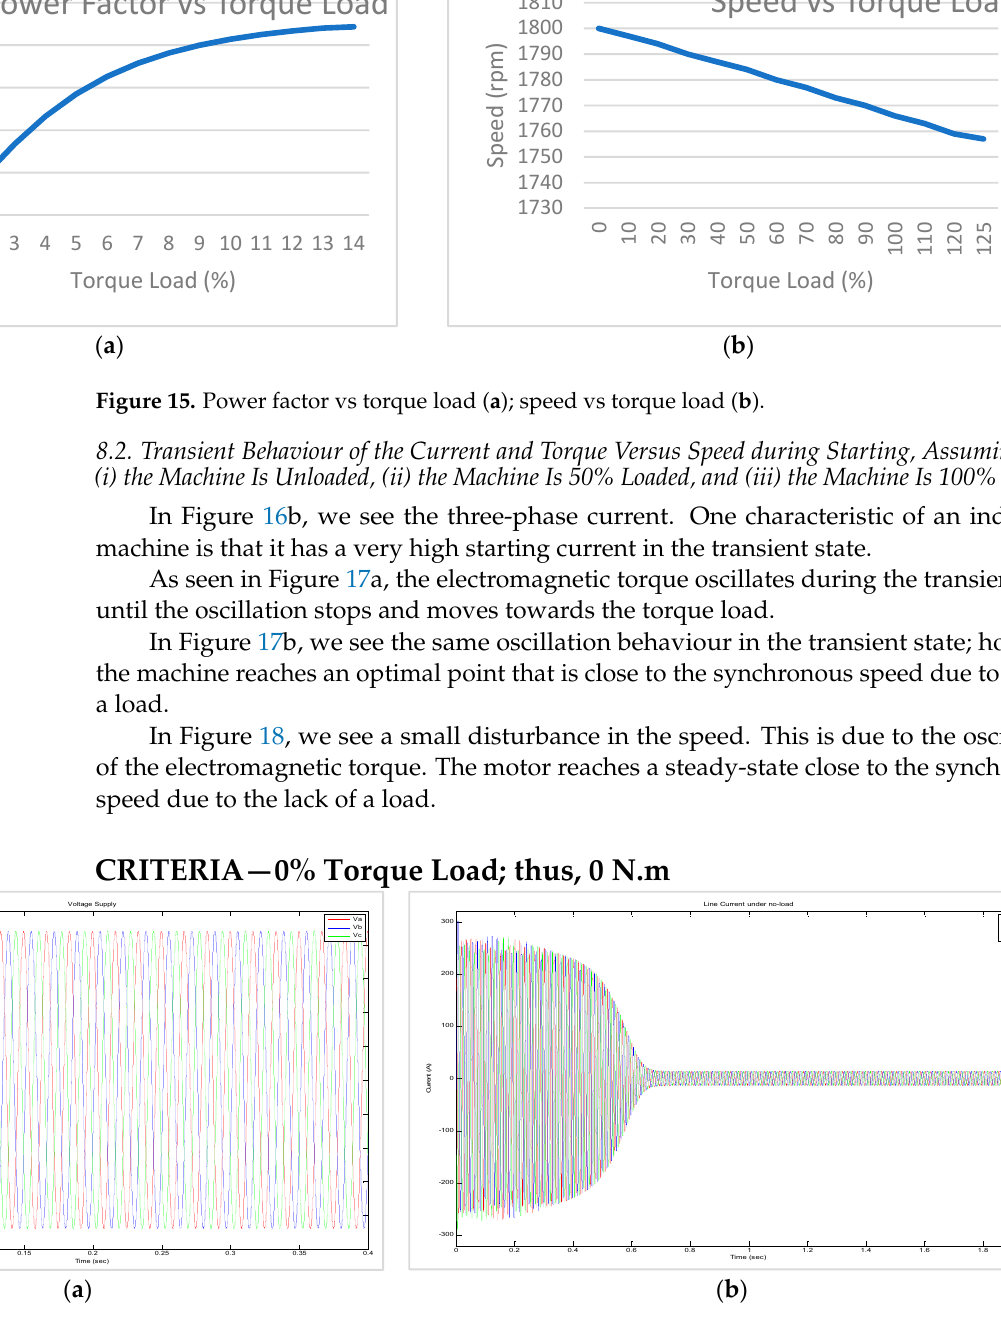
Figure 16. ( a ) Voltage supply under no-load; ( b ) line currents under no-load.